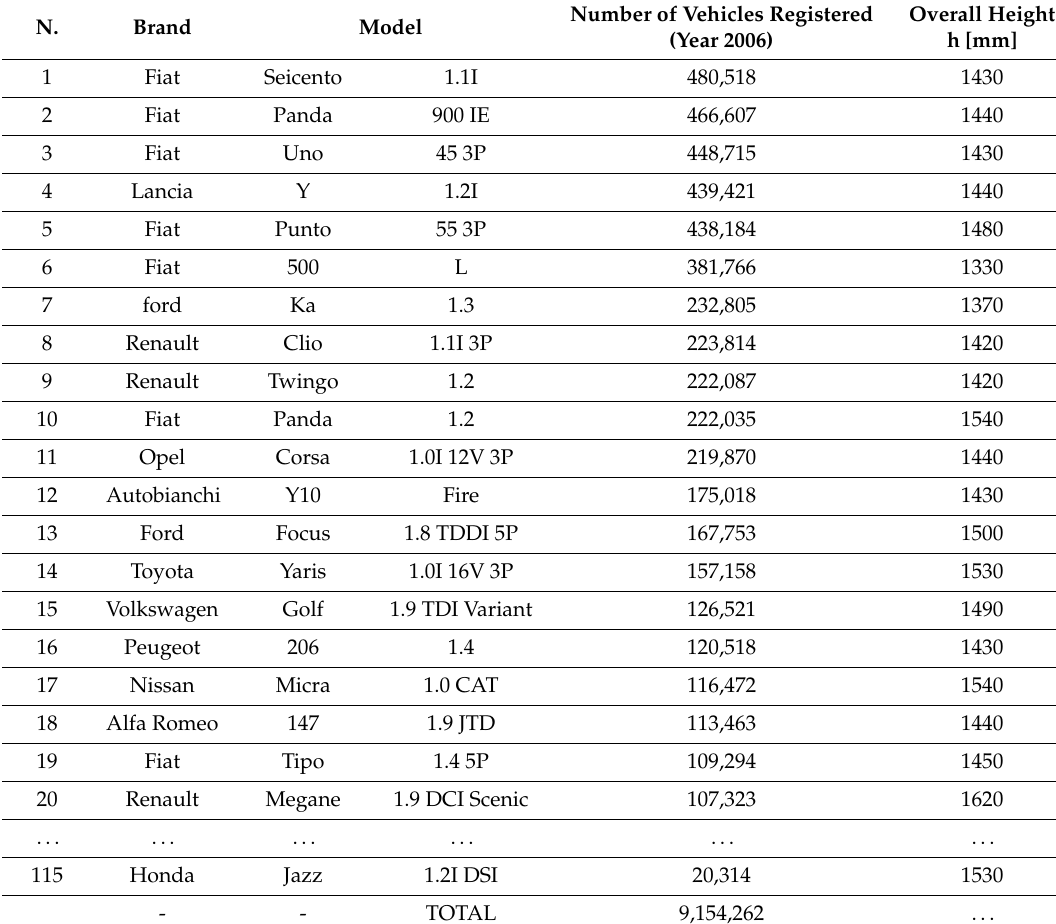
Table 3. Top 20 car models registered in Italy listed by number of vehicles sold.